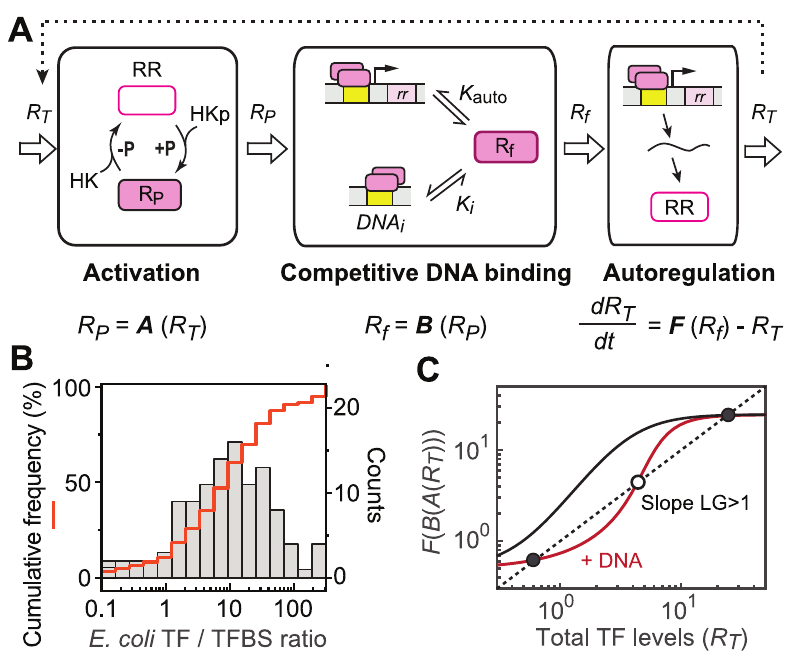
Fig 1. Presence of competing TF binding sites can lead to bistability in positively autoregulated systems. (A) Schematic of a typical autoregulated TCS. (B) Ratio of TF abundance to the number of TFBSs for E . coli TFs. The histogram shows the distribution of TFs with different TF/TFBS ratios and the red line indicates the cumulative frequency of TFs with ratios smaller than the corresponding histogram bin. (C) Steady states determined by the intersections of the autoregulated transcription function (solid lines) and the TF dilution/degradation (dotted line). An increase in competing TFBSs (+ DNA) can lead to multiple intersections, including two stable steady states (solid circles) and one unstable steady state (open circle), converting a monostable system (black) to bistable (red).